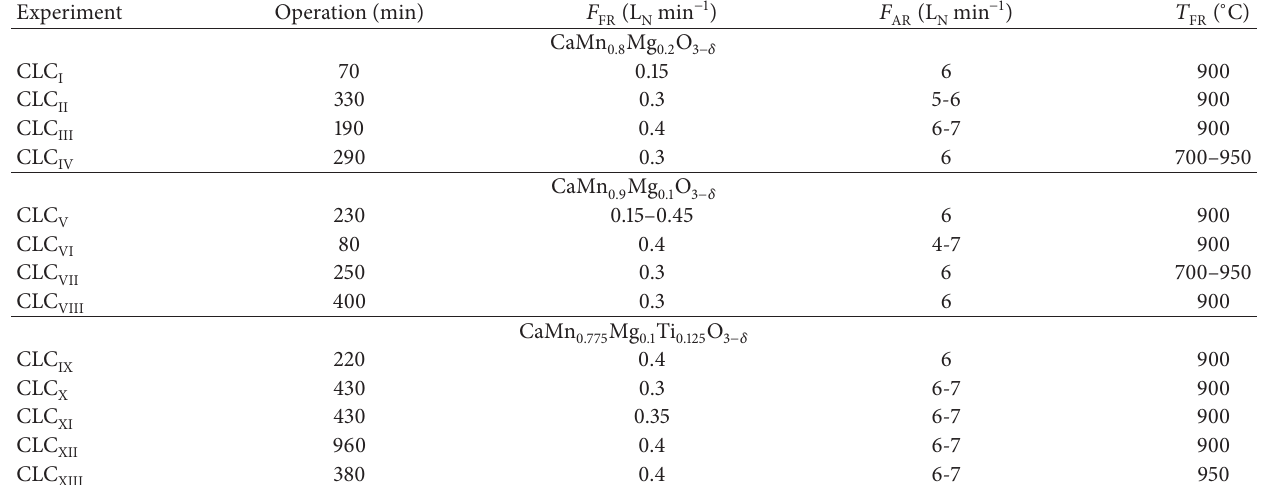
Table 2: List of experiments with natural